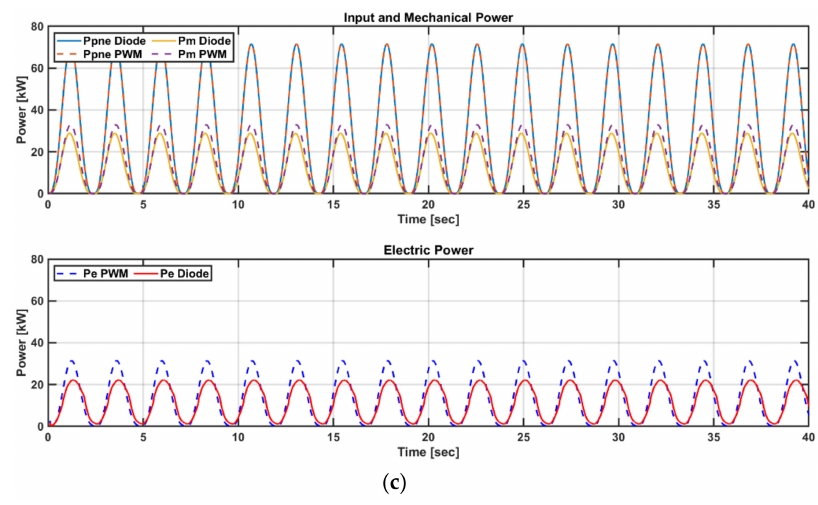
Figure 18. Power generation result using the integrated simulation of the PTO system under high regular wave conditions ( v t = 0~35 m / s and T = 4.75 s): ( a ) Diode converter; ( b ) PWM converter; ( c ) Power performance comparison according to topology.